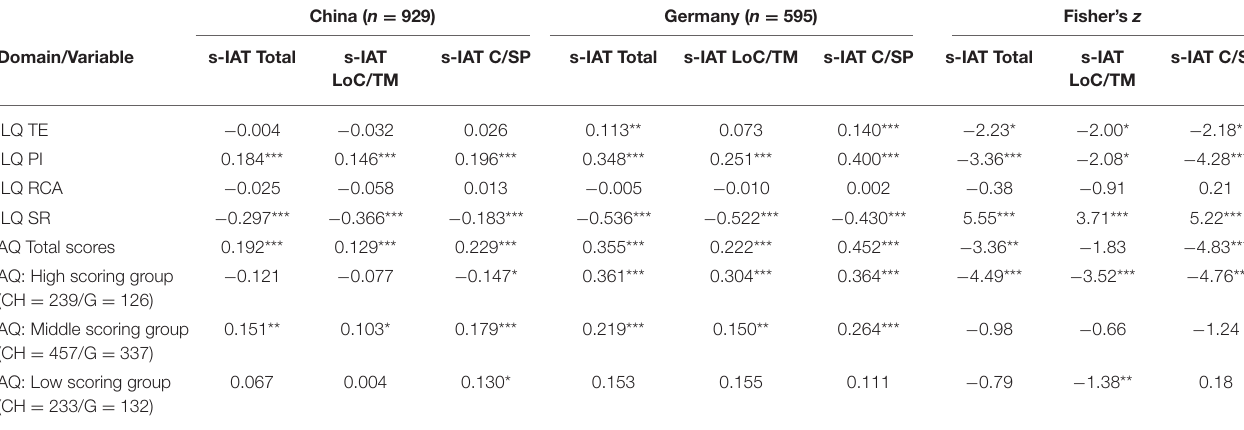
TABLE 3 | Correlations between s-IAT scores, AQ scores and ILQ dimension scores (Pearson correlations) including Fisher’s z comparison. China ( n =